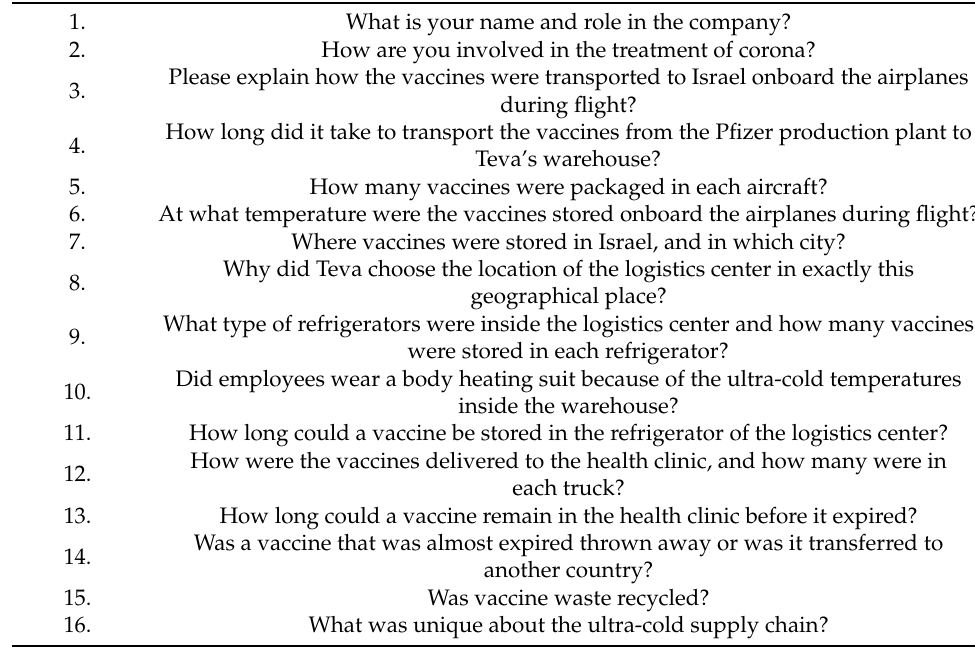
Table 2. Questionnaire for the interviews with the supply chain managers.